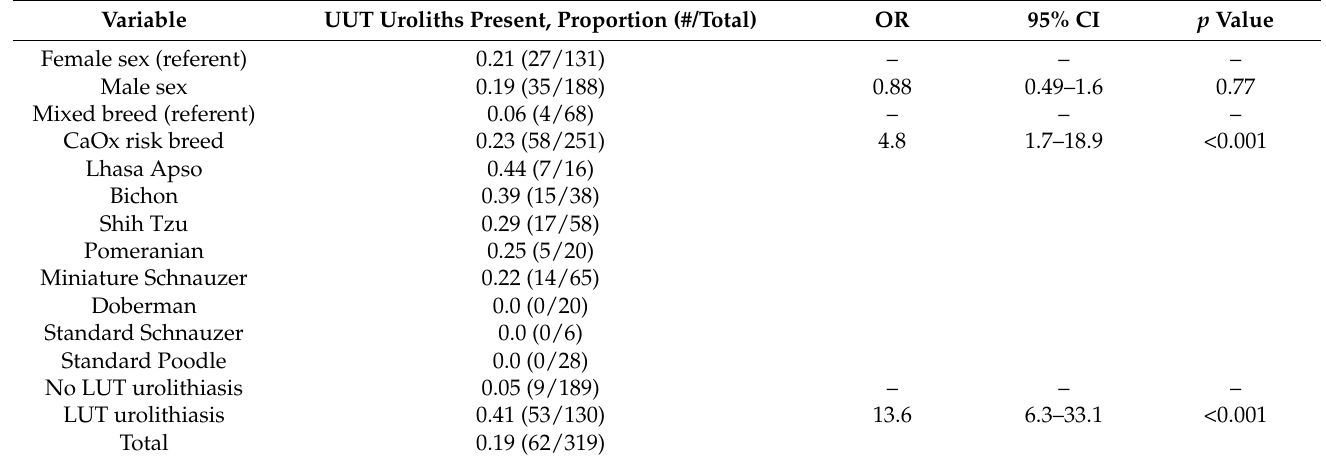
Table 2. Prevalence of radiographically apparent upper urinary tract (UUT) uroliths and their association with patient variables in 319 dogs, including 68 mixed breed dogs and 251 dogs of breeds reported to have increased risk for calcium oxalate (CaOx) uroliths.